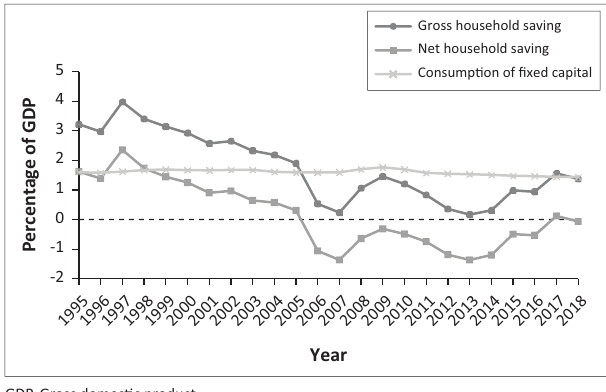
FIGURE 2: Gross and net saving of households, 1995 to